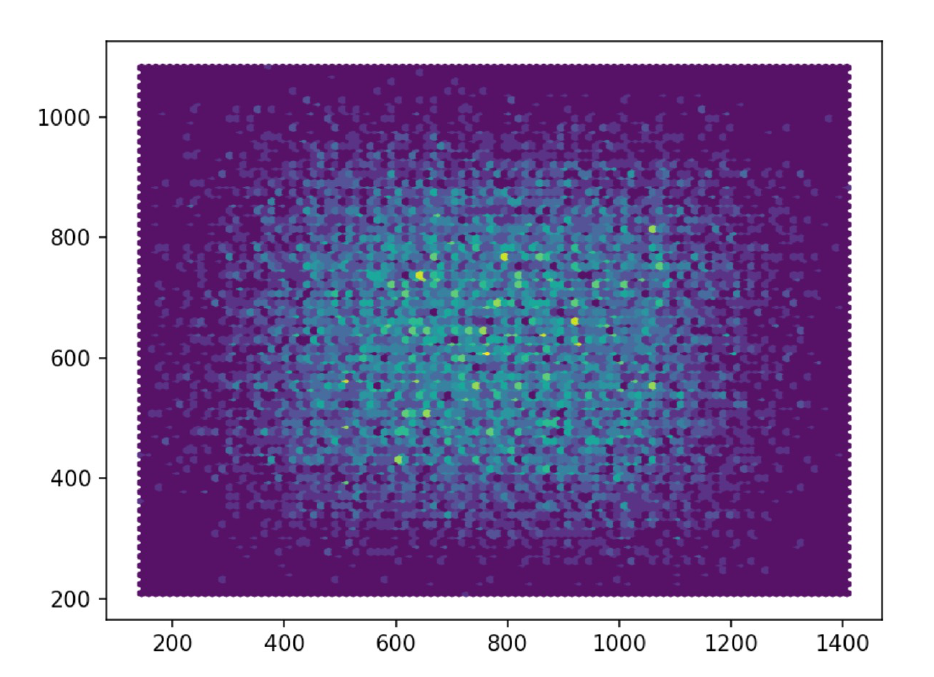
Figure 3. Histogram of the corner distribution over the image area in the SWD data set for the telephoto